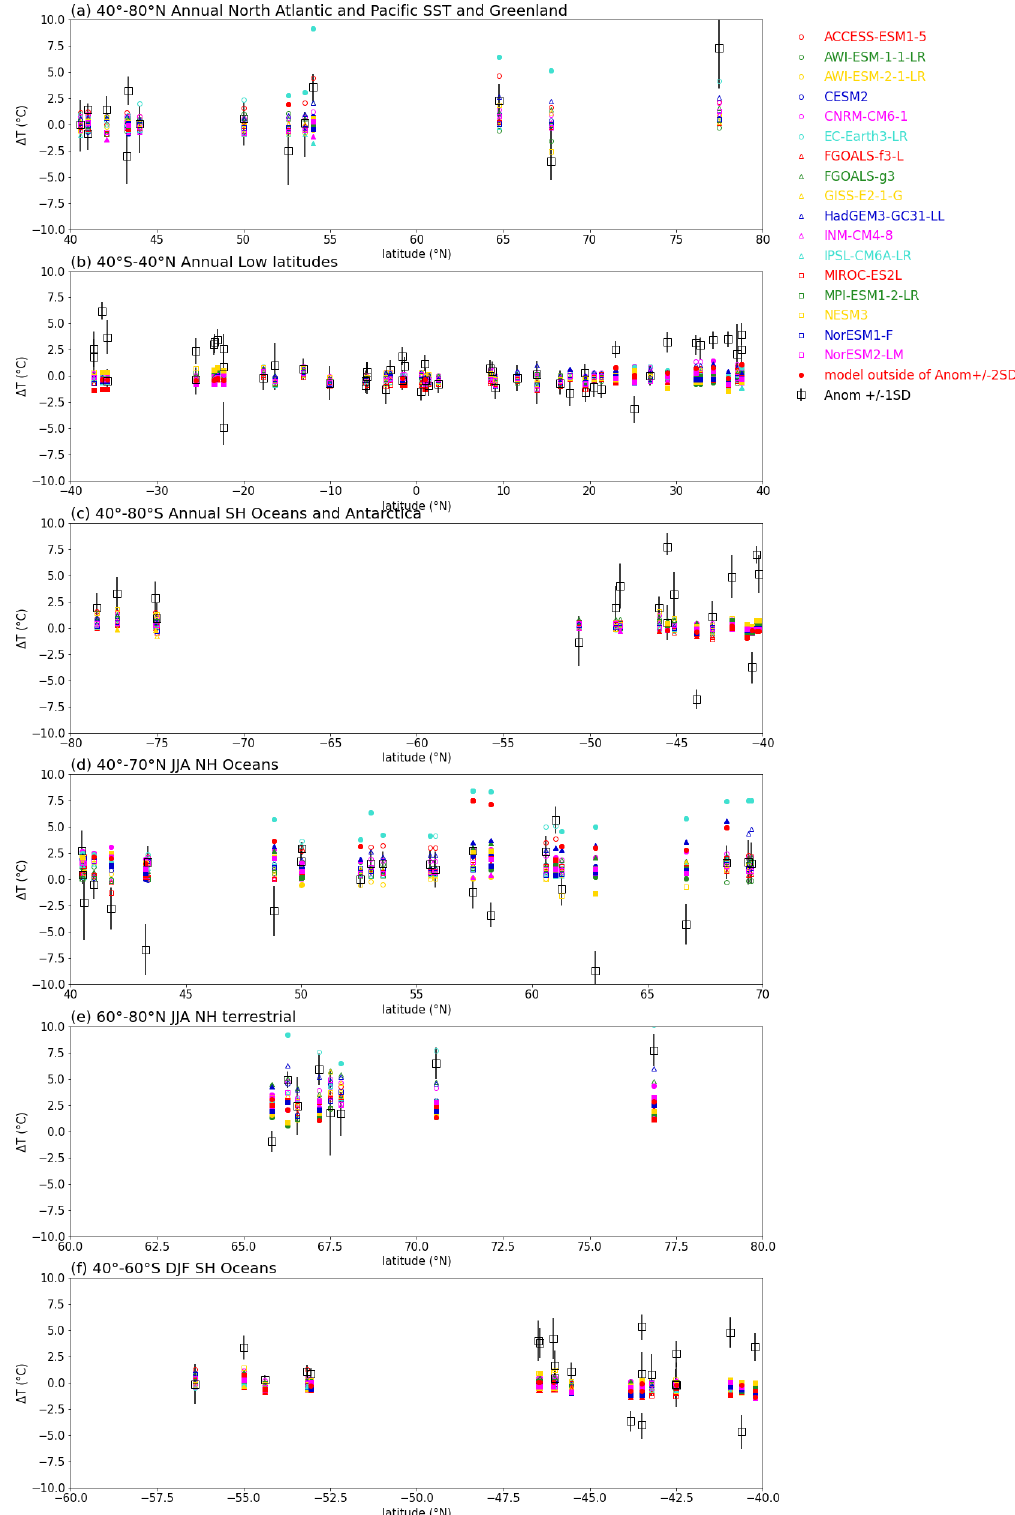
Figure 12. Comparison of proxy estimates of surface temperature anomalies ( ± 1 standard deviation) with modeled temperature anomalies at the locations of the proxy data. Annual anomalies for (a) 40–80 ◦ N, North Atlantic and Pacific SST and Greenland; (b) 40 ◦ S–40 ◦ N SST; and (c) 40–80 ◦ S SH ocean SST and Antarctic surface air temperature. Seasonal anomalies for (d) 40–70 ◦ N, JJA NH oceans; (e) 60–80 ◦ N, JJA NH terrestrial; and (f) 40–60 ◦ S, DJF SH oceans. All units are degrees Celsius. Data and model values supporting this figure can be found in Tables